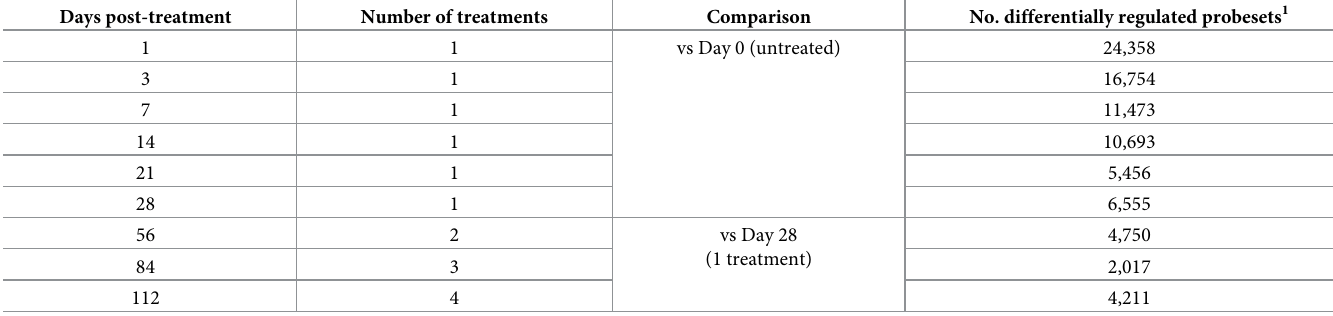
Table 1. Kinetic effects of laser resurfacing treatment(s) on gene expression in human skin. Days post-treatment Number of treatments